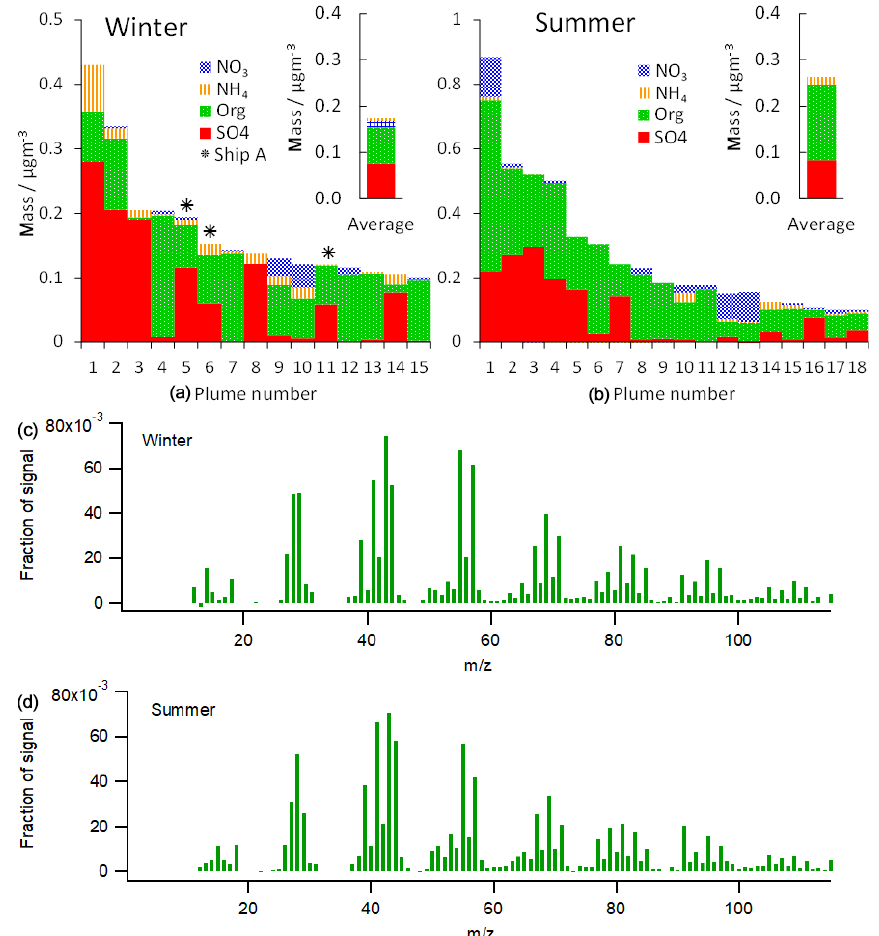
Figure 3. (a, b) Mass concentration and composition of the particle constituents nitrate (NO 3 ), ammonium (NH 4 ), total organics (Org), and sulfate (SO 4 ) of ship plumes with an average mass content larger than 0.1µgm − 3 , measured with the SP-AMS. Panel (a) shows plumes in winter and panel (b) shows plumes in summer sorted in decreasing order of total mass conc. Inserted bar plot shows the average of all plumes. The stars mark the plumes from the same ship passing at three different occasions (plume nos. 5, 6, and 11). (c, d) Average organic mass spectra of plumes in the winter and summer measured with the